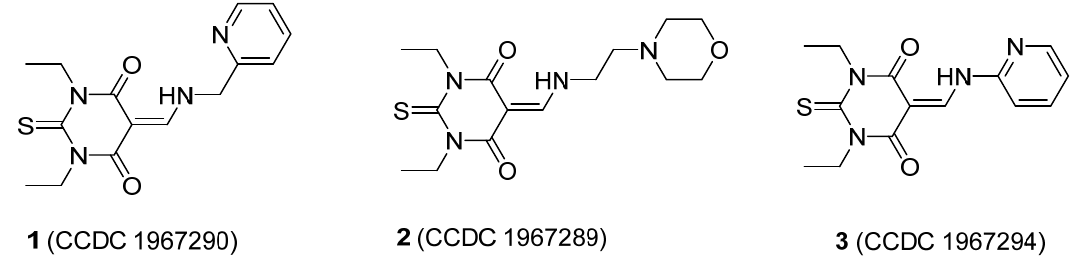
Figure 1. Structures of the three enamine/imine TBA derivatives 1 − 3.